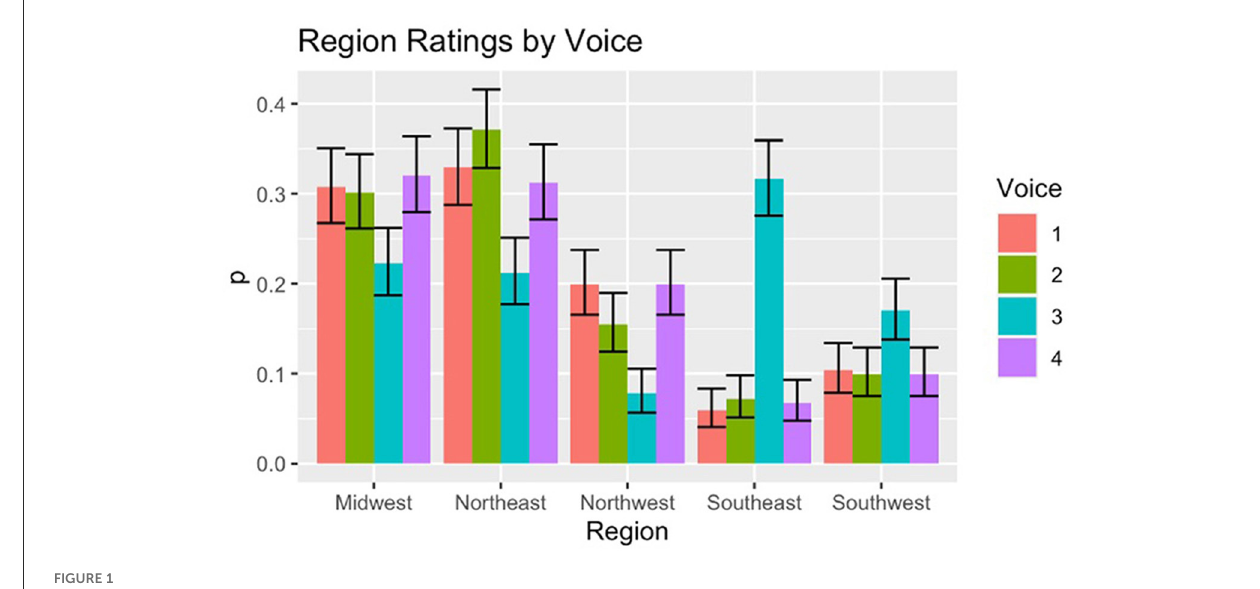
FIGURE1 Ratings for region by voice.